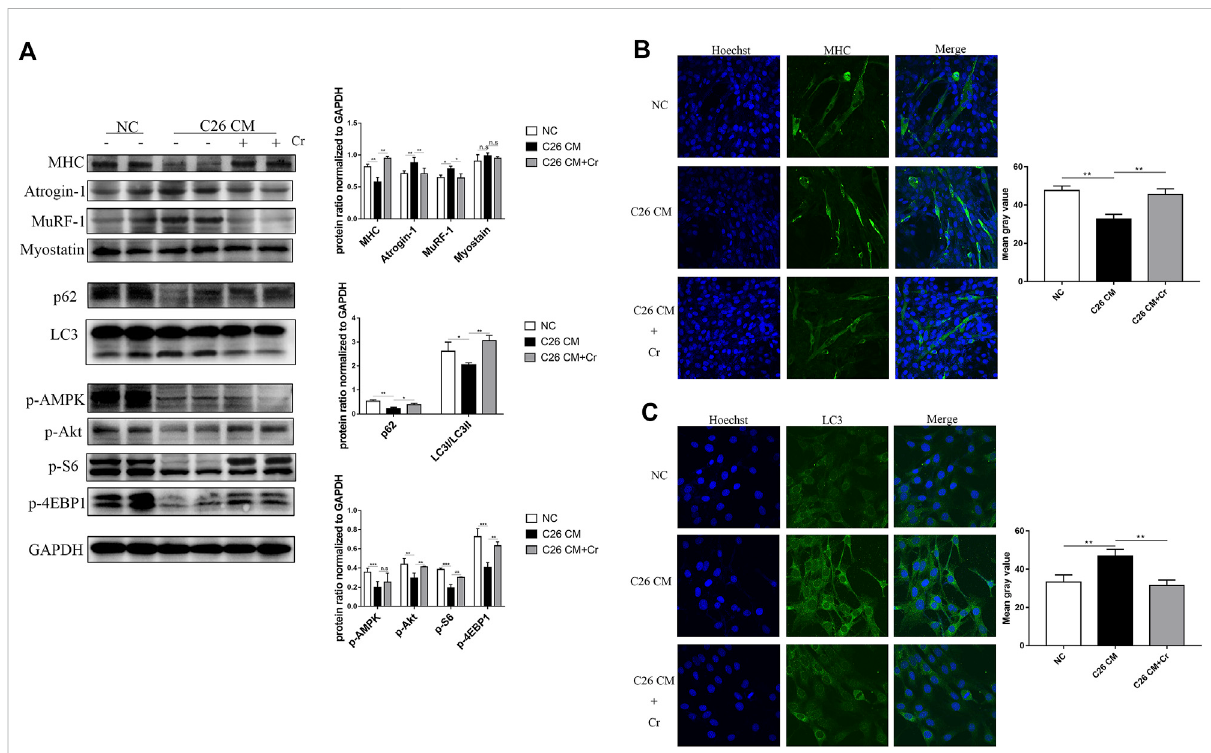
FIGURE 5 Supplementation with creatine prevents myotubular atrophy by inhibiting the activation of UPS and ALS. (A) Western blot analysis was performedtoevaluatetheexpressionofMHC,Atrogin-1,MuRF-1,Myostatin,p62,LC3,p-AMPK, p-Akt,p-S6andp-4EBP1intheNCgroup, cachexia groupandcachexia+Crgroup(mean±SD, n =6).* p < 0.05,** p < 0.01,*** p < 0.001. (B) Myosinheavychain(MHC)expressioninthecellmodelwas evaluated by IF staining. MHC, green, DAPI, blue. The bar graph shows the mean gray value of different groups. (C) LC3 expression in the cell model was evaluated by IF staining. LC3, green, DAPI, blue. The bar graph shows the mean gray value of different groups. Data are expressed as the mean ± SD, ** p <